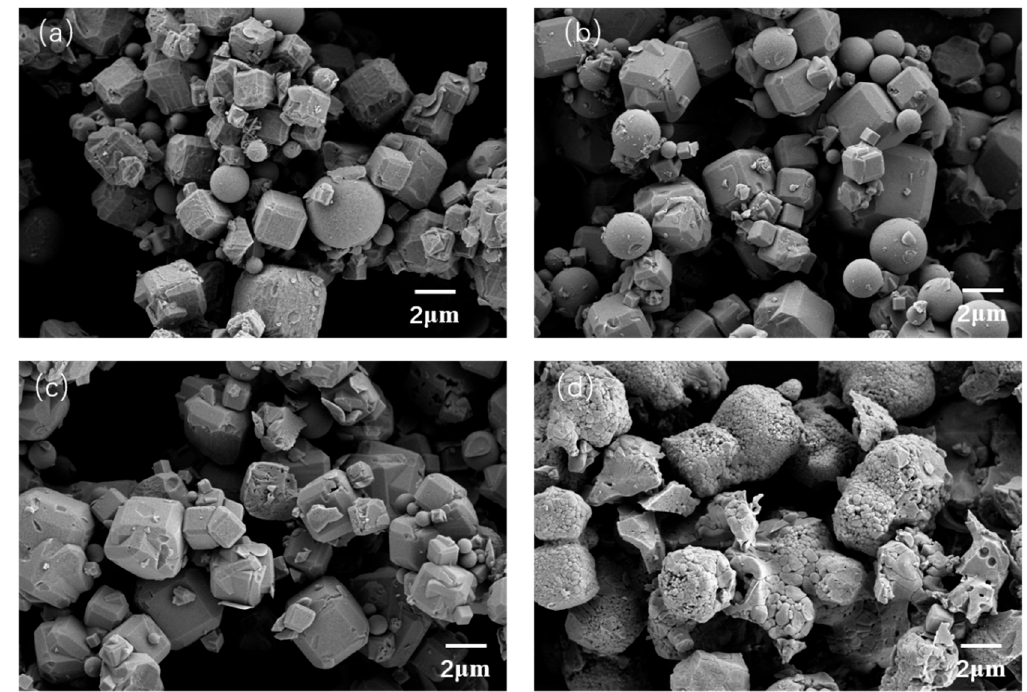
Figure 6. Scanning electron microscopy (SEM) images of the products prepared with different Na 2 CO 3 content ( a ) 0 g; ( b ) 0.2 g; ( c ) 0.4 g; and ( d ) 0.6 g.